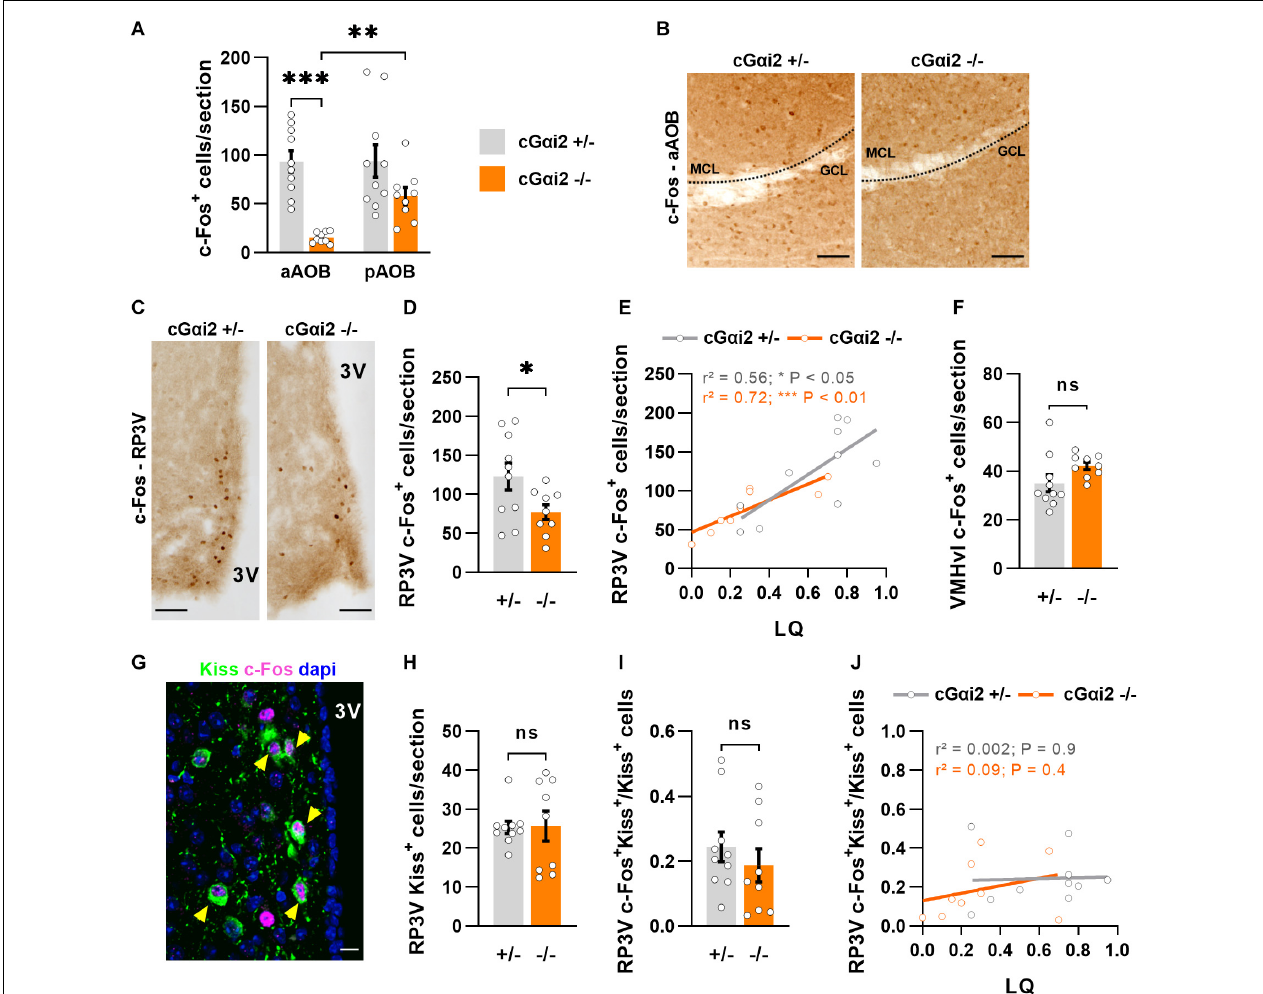
FIGURE 4 | Reduced neural activity in the AOB and RP3V of G α i2-mutant females. (A,B) Analysis of c-Fos immunodetection in the AOB of cG α i2 + / − ( N = 10) and cG α i2 − / − ( N = 9) females after sexual behavior. (A) Quantification of c-Fos+ cells per section reveals a decreased c-Fos activation in the aAOB of cG α i2 − / − [Two-way repeated measures ANOVA: (genotype) F ( 1 , 17 ) = 18.28, P < 0.001; (region) F ( 1 , 17 ) = 5.82, P < 0.05; (genotype × region) F ( 1 , 17 ) = 5.53, P < 0.05; Bonferroni post hoc tests: cG α i2 − / − aAOB vs. cG α i2 − / − pAOB, P < 0.01; cG α i2 + / − aAOB vs. cG α i2 − / − aAOB P < 0.001; other comparisons P = 0.06–0.9). All three AOB layers were quantified. (B) Examples of c-Fos immunolabeling in the aAOB of cG α i2 + / − and cG α i2 − / − females after sexual behavior. Scale bars, 50 µ m. (C–E) c-Fos immunodetection in the RP3V of cG α i2 + / − ( N = 10) and cG α i2 − / − ( N = 9) females. (C) Examples of c-Fos immunodetection in the RP3V of cG α i2 + / − and cG α i2 − / − females after sexual behavior. Scale bars, 50 µ m. (D) Quantification of c-Fos+ cells per section in the RP3V of cG α i2 − / − ( t -test: P < 0.05). (E) Positive correlation between the number of RP3V-c-Fos+ cells and lordosis quotient (LQ) in cG α i2 + / − and cG α i2 − / − females (Pearson’s correlation; cG α i2 + / − : r 2 = 0.56, P < 0.05; cG α i2 − / − : r 2 = 0.72, P < 0.01). (F) c-Fos immunodetection in the VMHvl of cG α i2 + / − ( N = 10) and cG α i2 − / − ( N = 9) females after sexual behavior. Quantification is not different between genotypes ( t -test: P = 0.08). (G–J) Analysis of kisspeptin and c-Fos double immunostaining in the RP3V. (G) Example of Kiss and c-Fos immunostaining in the RP3V of a cG α i2 + / − female. The yellow arrows indicate double labeled c-Fos-Kiss neurons. Scale bar, 10 µ m. Quantifications of Kiss+ neurons (H) and double-labeled c-Fos+Kiss+ neurons (I) are not different between genotypes (Mann-Whitney: P = 0.9; t -test: P = 0.4, respectively). (J) Correlative analysis between the number of c-Fos+Kiss+ cells in the RP3V and the LQ (Pearson’s correlation; cG α i2 + / − : r 2 = 0.002, P = 0.9; cG α i2 − / − : r 2 = 0.09, P = 0.4). AOB, accessory olfactory bulb (aAOB, anterior AOB; pAOB, posterior AOB); 3V, third ventricle; RP3V, rostral periventricular area of the third ventricle; VMHvl, ventrolateral part of the ventromedial hypothalamic nucleus; Kiss, kisspeptin. * P < 0.05; ** P < 0.01; *** P <